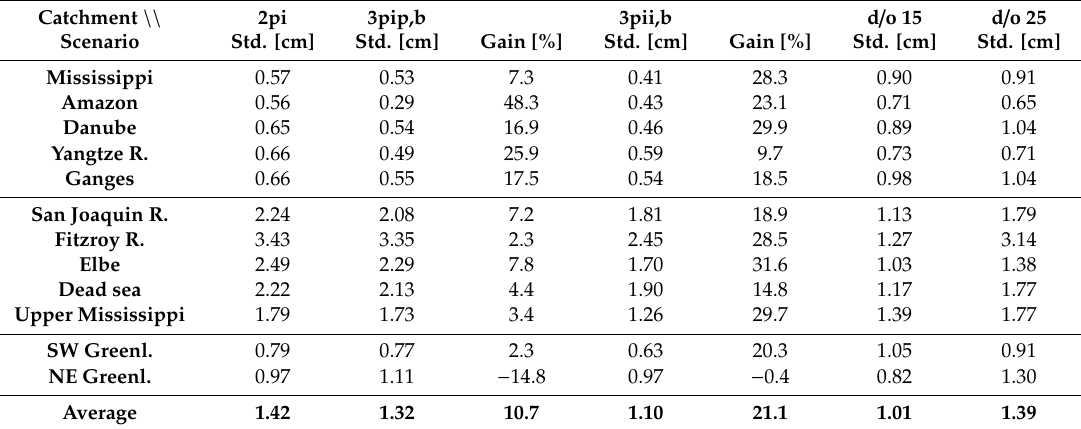
Table 7. Standard deviation of Scenario 2pi, 3pip,b, and 3pii,b up d / o 50 (with daily d / o 15) and the gain of the triple-pair scenarios compared to the double pair scenario. Computed over one year of the indicated catchments in cm EWH. Clustered: Big catchments, small catchments, ice drainage basins according to the Rignot basins, IMBIE project (http: // imbie.org / imbie-2016 / drainage-basins / ). Additionally, in the last two columns are the standard deviation of daily solutions based on Scenario 3pii,b, once co-estimated up to d / o 15 and once co-estimated up to d / o 25.